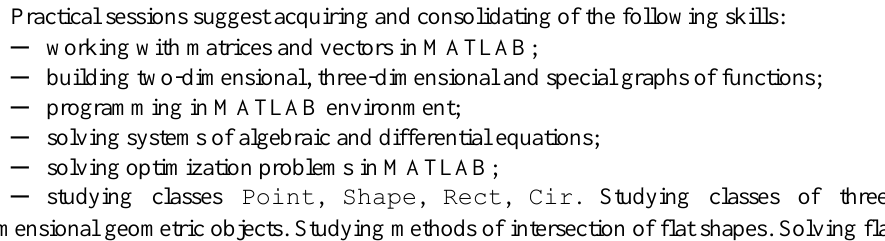
Fig. 2. Approximation of the function graph in online version of